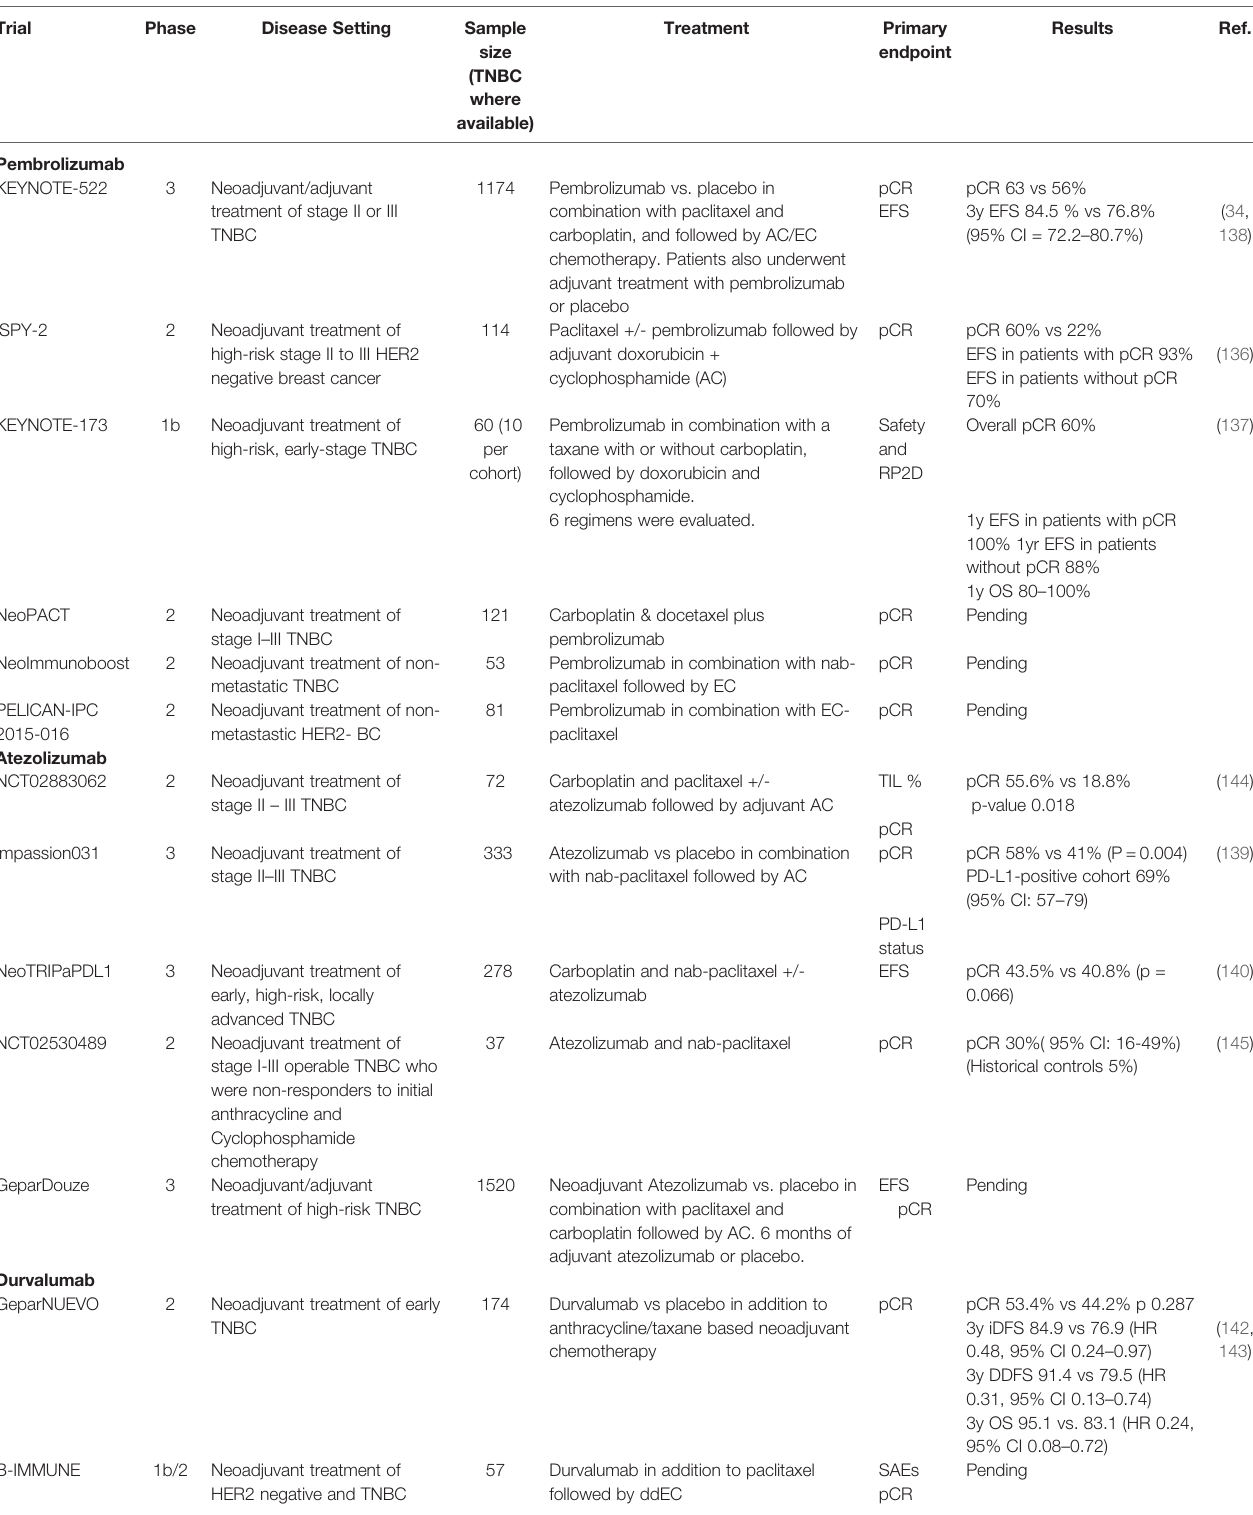
TABLE 8 | Major neoadjuvant trials that include immune checkpoint inhibitors in patients with stage I – III TNBC. Neoadjuvant Trials